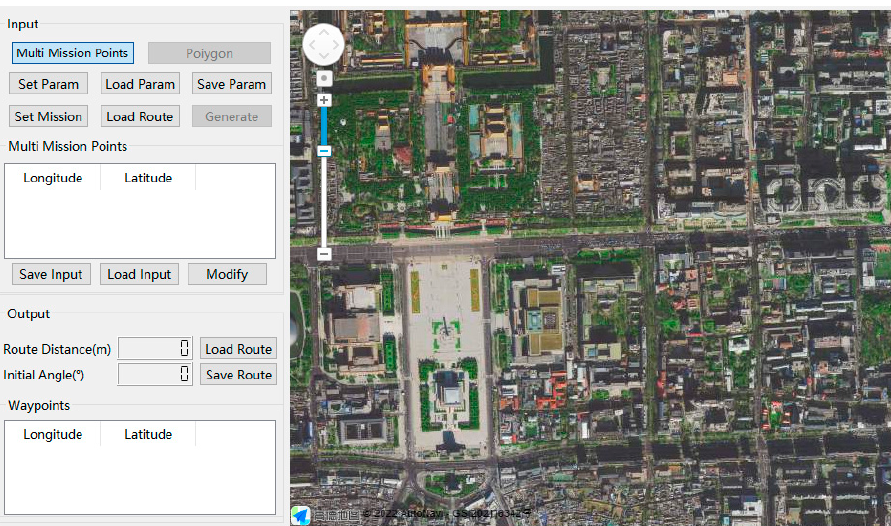
Figure 7. Layout of route planning simulation software developed for multi-mission-point route planning. After selecting the “Multi-Mission Points” mode, the user can click “Set Mission”, then click on the map to set the coordinates of the multi-mission points, and finally click “Generate”. And the optimal route will be displayed on the map.